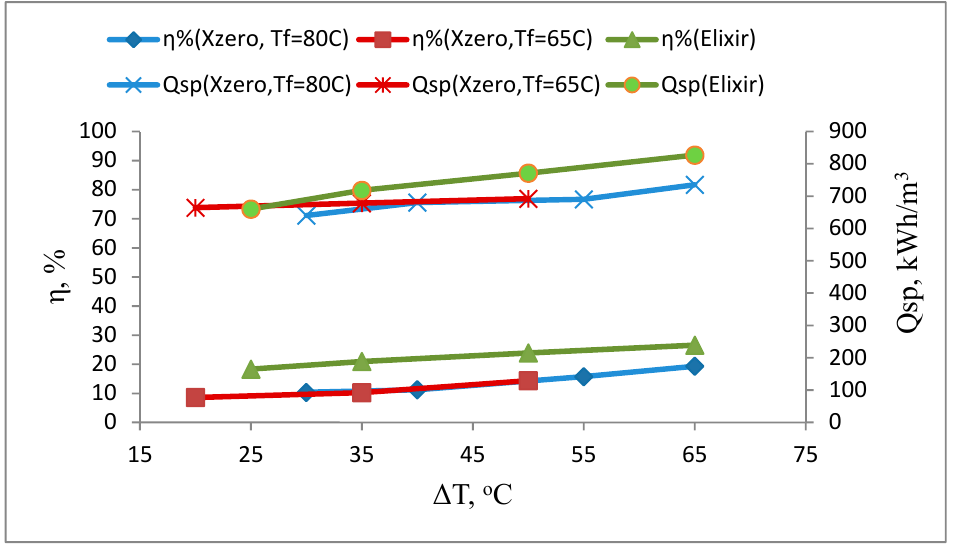
Figure 6. Performance of Xzero and Elixir500 AGMD systems regarding exergy efficiency and specific heat demand at different feed–coolant temperature differences for fixed feed temperatures of 80 °C (for both modules) and 65 °C (only for Xzero).